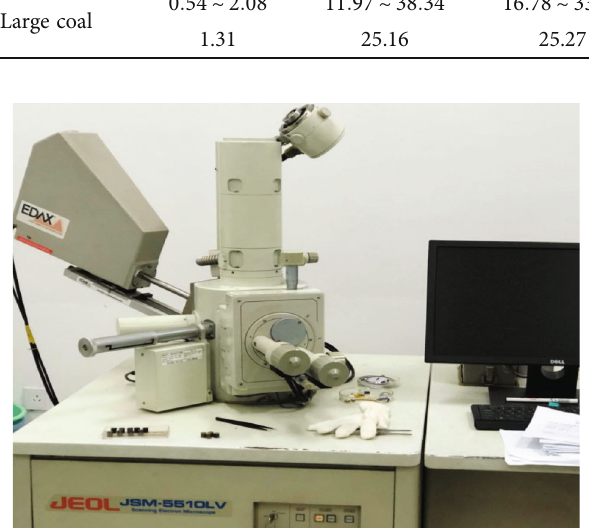
Figure 1: JSM-5510LV scanning electron microscope.